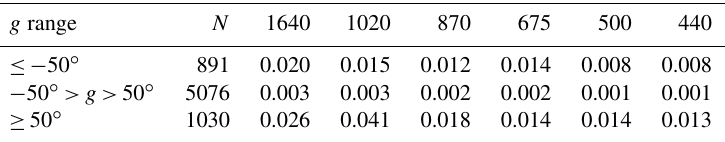
Table 3. Average AOD difference between corrected and non-corrected AOD ( (cid:49) AOD) measured at the Izaña station as a function of the Moon’s phase angle ( g ) in degrees in a 59-night period transition coherence test in 2014. The umber of nighttime measurements ( N ) is included.